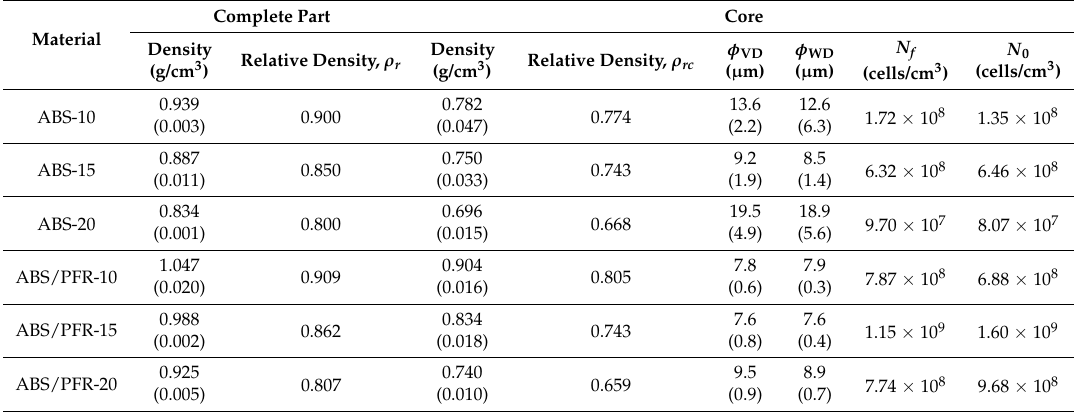
Table 1. Structural analysis of ABS and ABS/PFR microcellular